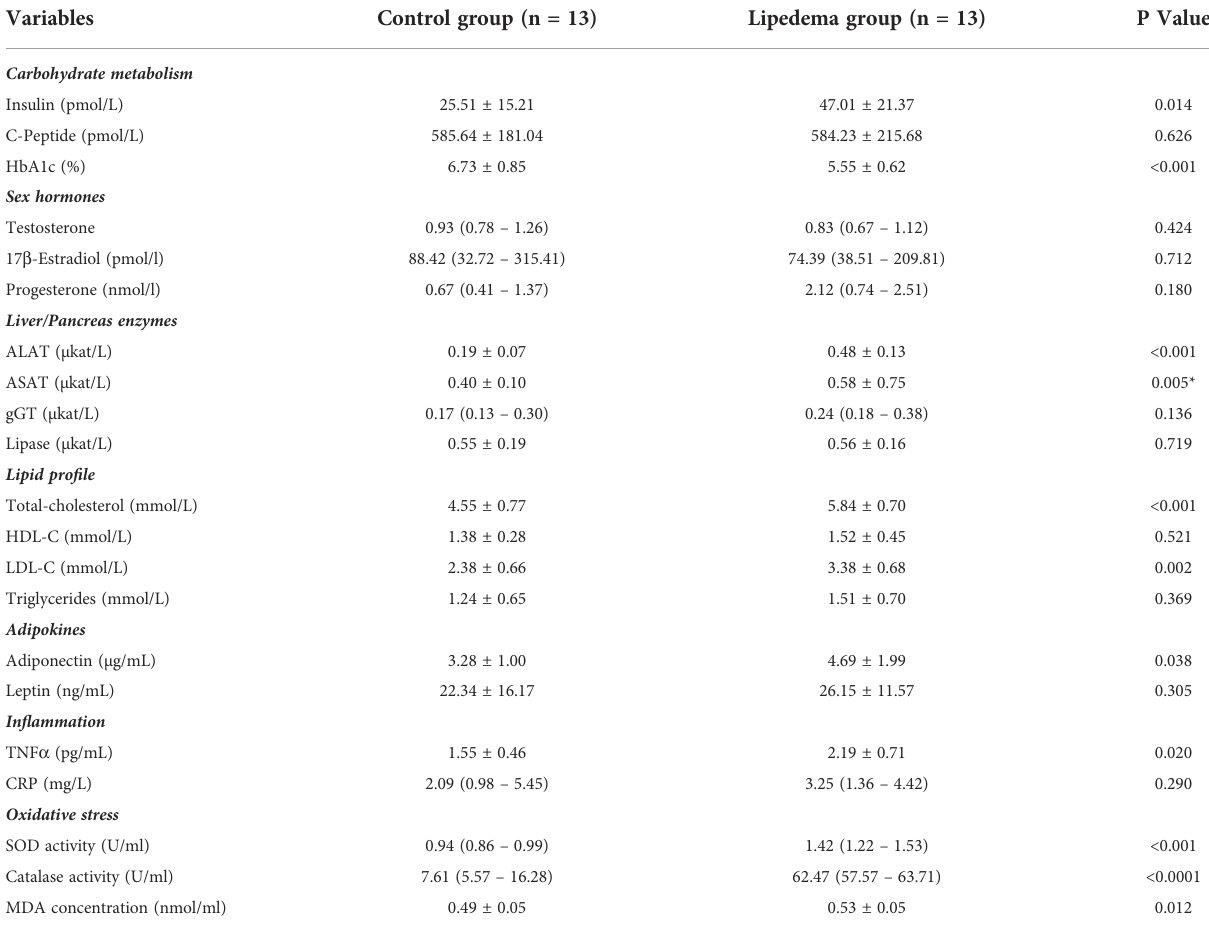
TABLE 2 Systemic metabolic parameters and biochemical